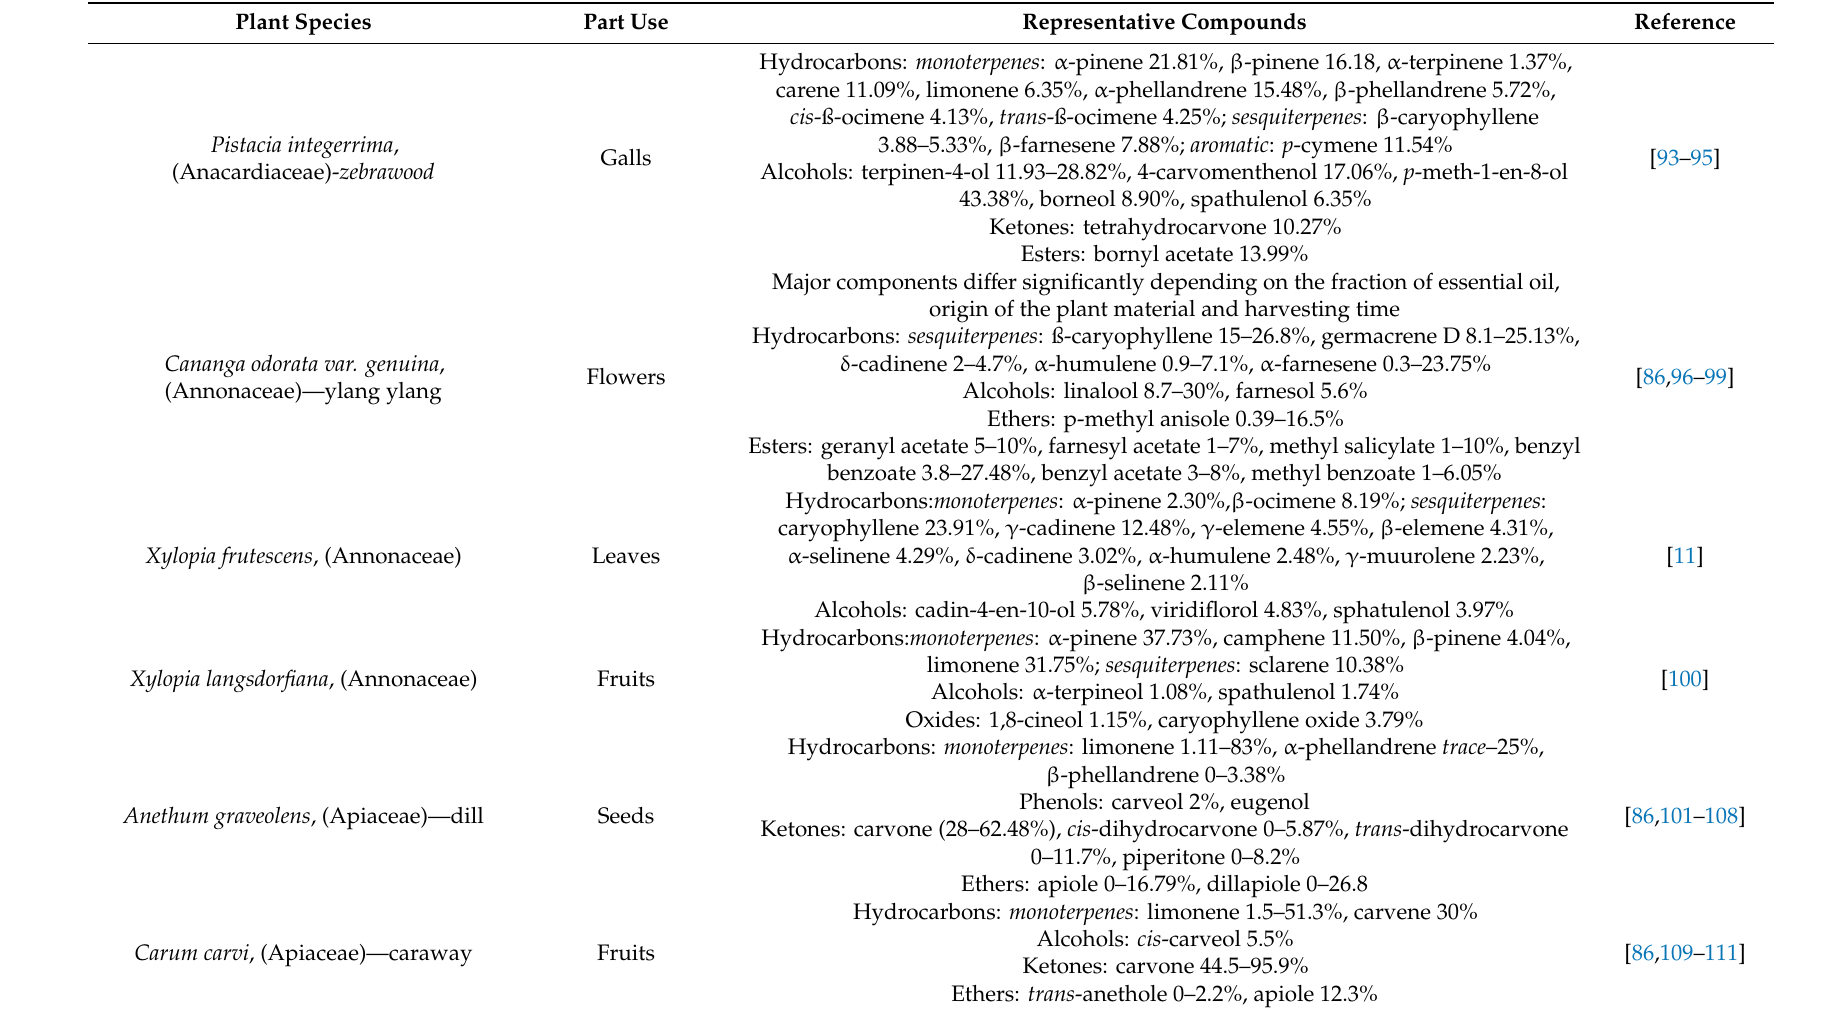
Table 3. Chemical composition of the studied antispasmodic essential